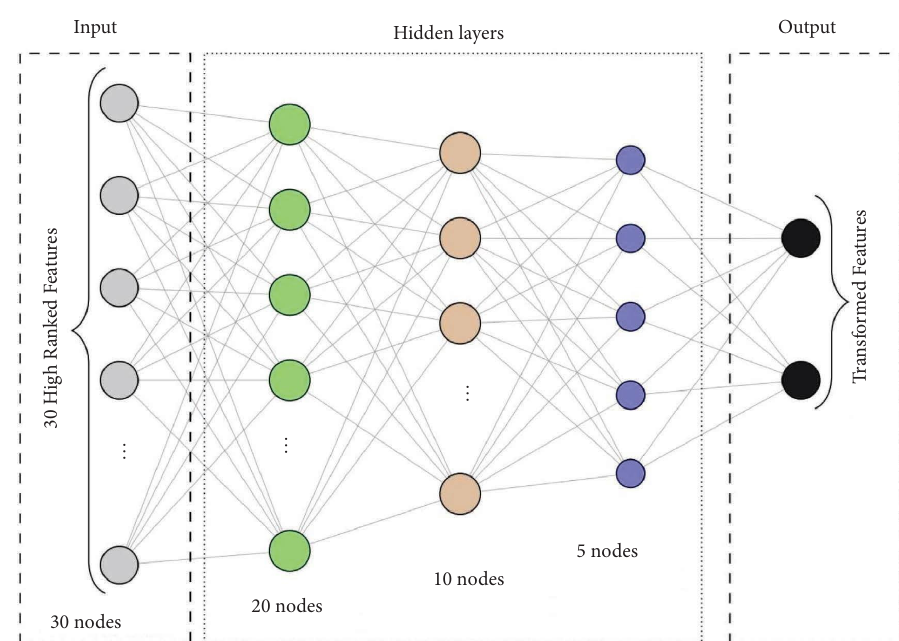
Figure 8: Te details of the Siamese